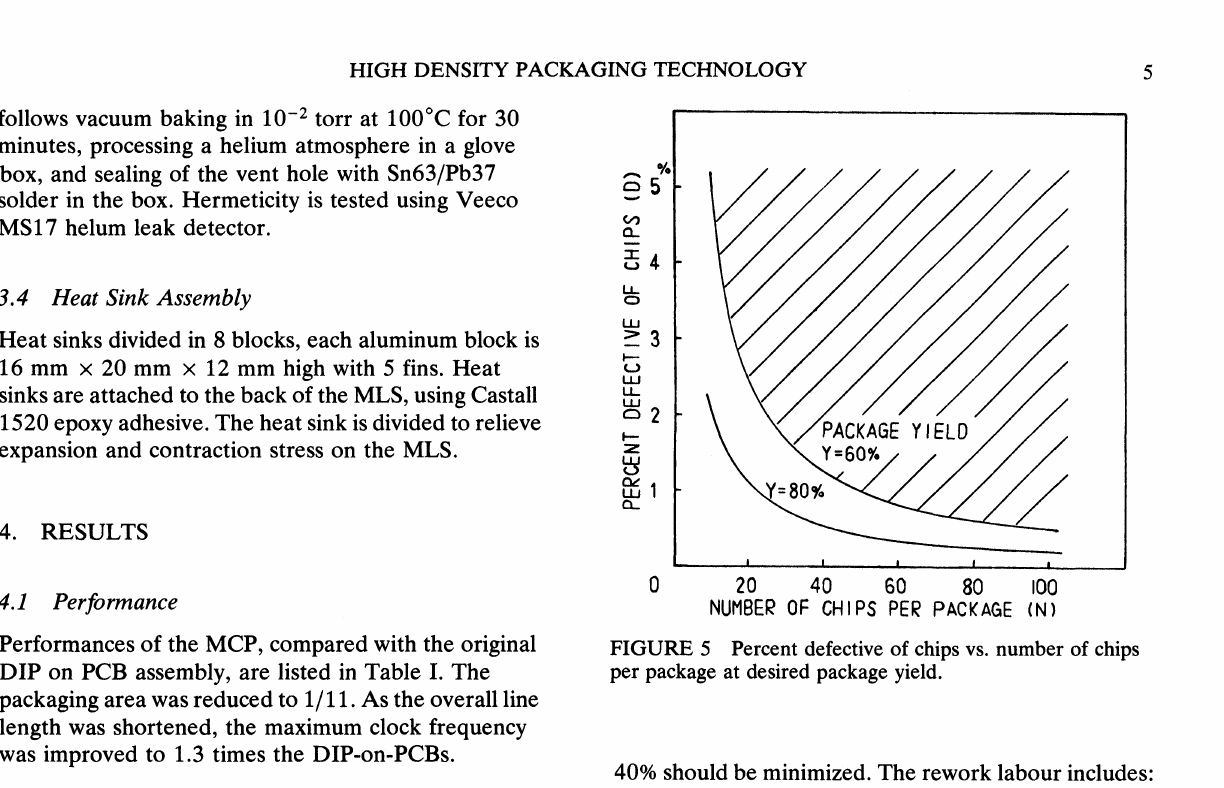
FIGURE 5 Percent defective of chips vs. number of chips per package at desired package